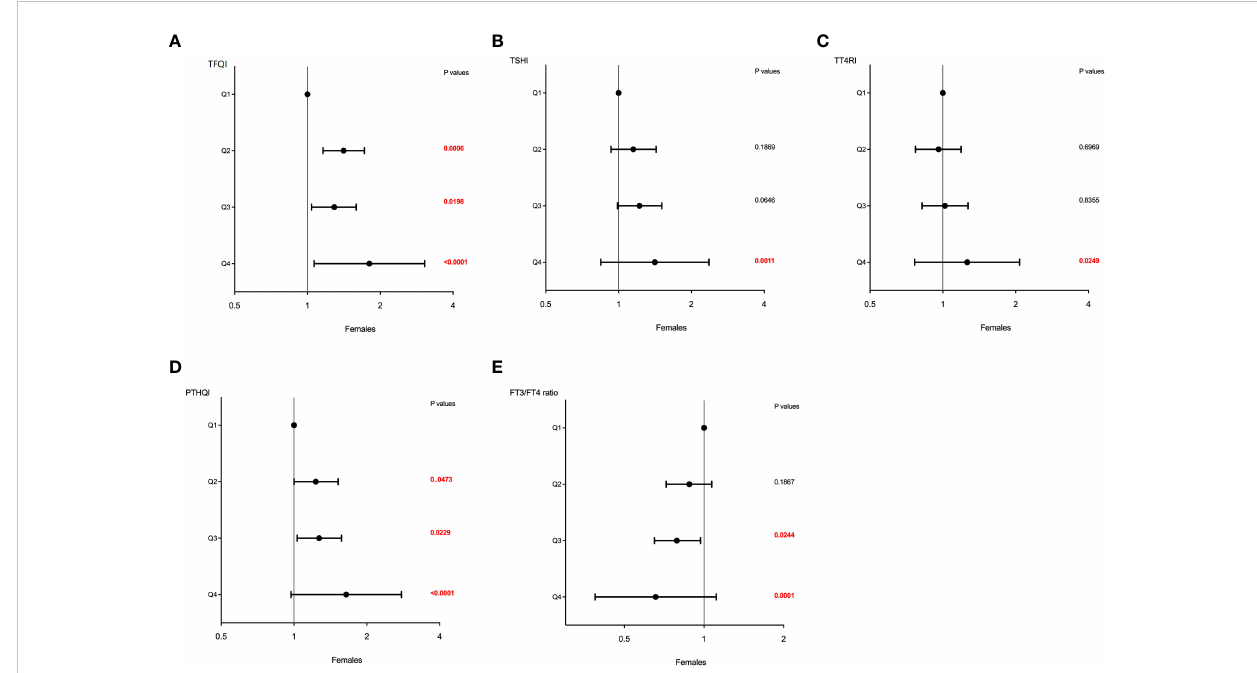
FIGURE 4 The forest maps of logistic regression analysis for the association between HUA and thyroid hormone sensitivity in women. (A) The ORs for HUA across TFQI quartiles. (B) The ORs for HUA across TSHI quartiles. (C) The ORs for HUA across TT4RI quartiles. (D) The ORs for HUA across PTHQI quartiles. (E) The ORs for HUA across FT3/FT4 ratio quartiles. Model was adjusted for age, BMI, dyslipidemia, diabetes, fatty liver, and hypertension. Q1, the fi rst quartile, Q2, the second quartile, Q3, the third quartile, Q4, the fourth